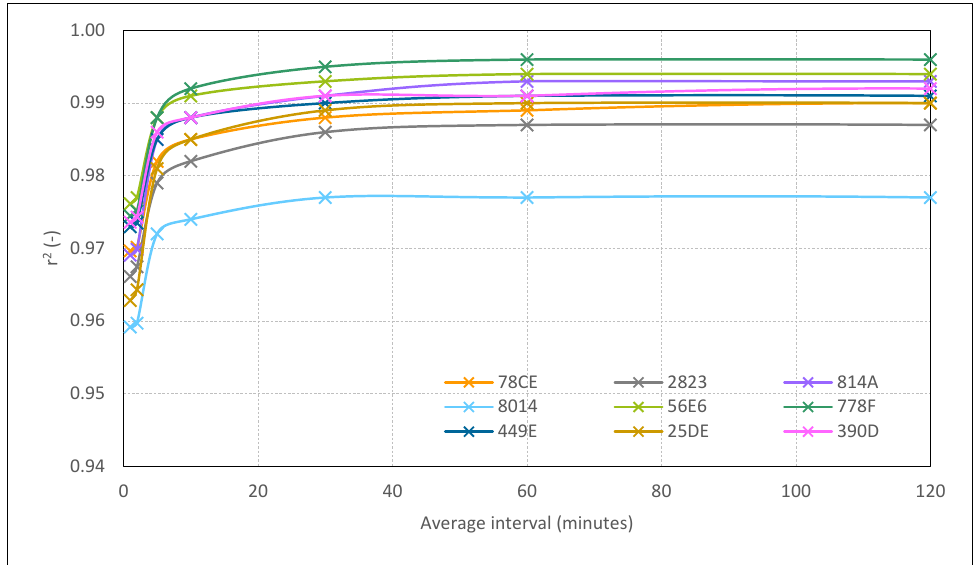
Figure 6. Benchmark set-up 2021. The r 2 value of the lineal regression of the measurements (serial numbers: 78CE, 2823, 814A, 8014, 56E6, 778F, 449E, 25DE, 390D) with sensor R01 Ref. Values obtained for raw data minutely recorded and average intervals of 1 min, 2 min, 5 min, 10 min, 30 min, 1 h and 2 h. Table 6. Offset regarding the reference sensor and spread of all the measurements, considering the benchmark test conducted in 2021. Raw Data Corrected